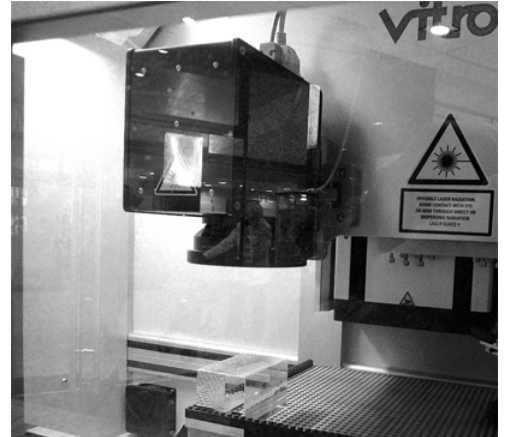
Figure 11. VITRO crystal laser engraving machine of company LOOXIS (Hannover, Germany); courtesy R.Titze (photography by W.Schuhr) (similar: CERION)